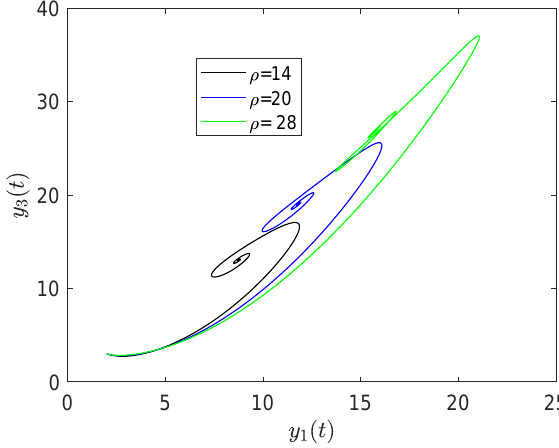
Figure 44. Phase portraits of y 1 and y 3 when varying ρ .